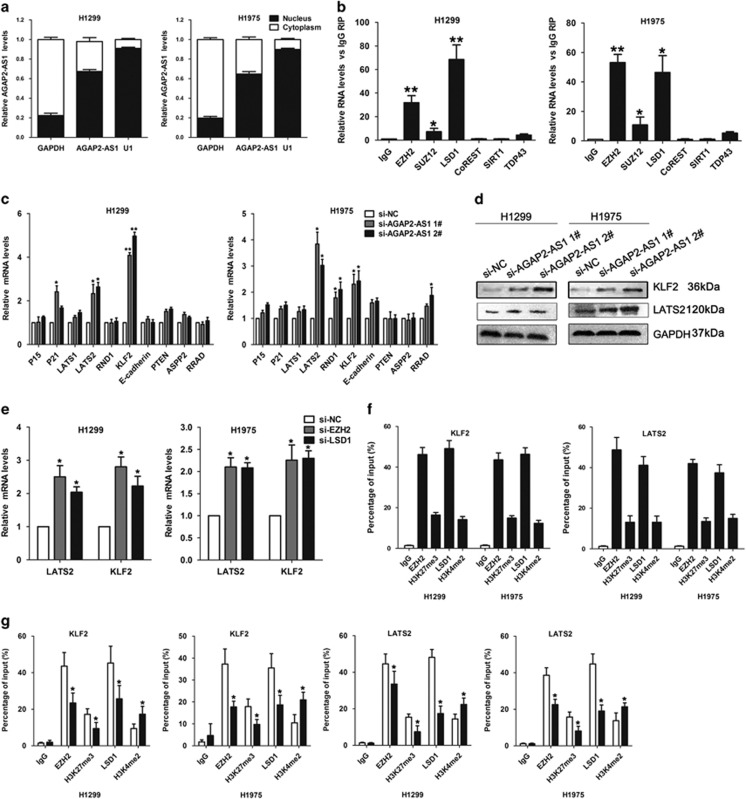
AGAP2-AS1 interacted with EZH2 and LSD1 to repress KLF2 and LATS2 expression. (a) Relative AGAP2-AS1 levels in cell cytoplasm or nucleus of H1299 and H1975 cells were detected by qPCR. GAPDH was used as cytoplasm control and U1 was used as nucleus control. The distribution of AGAP2-AS1 RNA in the cytoplasm or the nucleus was presented as percentage rate of total RNA. (b) RNA levels in immunoprecipitates with EZH2, SUZ12, LSD1, CoREST, SIRT1 and TDP43 were determined by qPCR. Expression levels of AGAP2-AS1 RNA were presented as fold enrichment relative to IgG immunoprecipitate. (c) The levels of P15, P21, LATS1, LATS2, RND1, KLF2, E-cadherin, PTEN, RRAD and ASPP2 messenger RNA were determined by qPCR when knockdown of AGAP2-AS1 in H1299 and H1975 cells. (d) The KLF2 and LATS2 protein levels were determined by western blot analysis in AGAP2-AS1 knockdown H1299 and H1975 cells. (e) The KLF2 and LATS2 expression levels were determined by qPCR when knockdown of EZH2 or LSD1 in H1299 and H1975 cells. (f and g) Chromatin immunoprecipitation-qPCR analysis of EZH2 and LSD1 occupancy, H3K27me3 and H3K4me2 binding to the KLF2 or LATS2 promoter regions in H1299 and H1975 cells, and IgG as a negative control. The mean values and S.E.M. were calculated from triplicates of a representative experiment. *P<0.05, **P<0.01